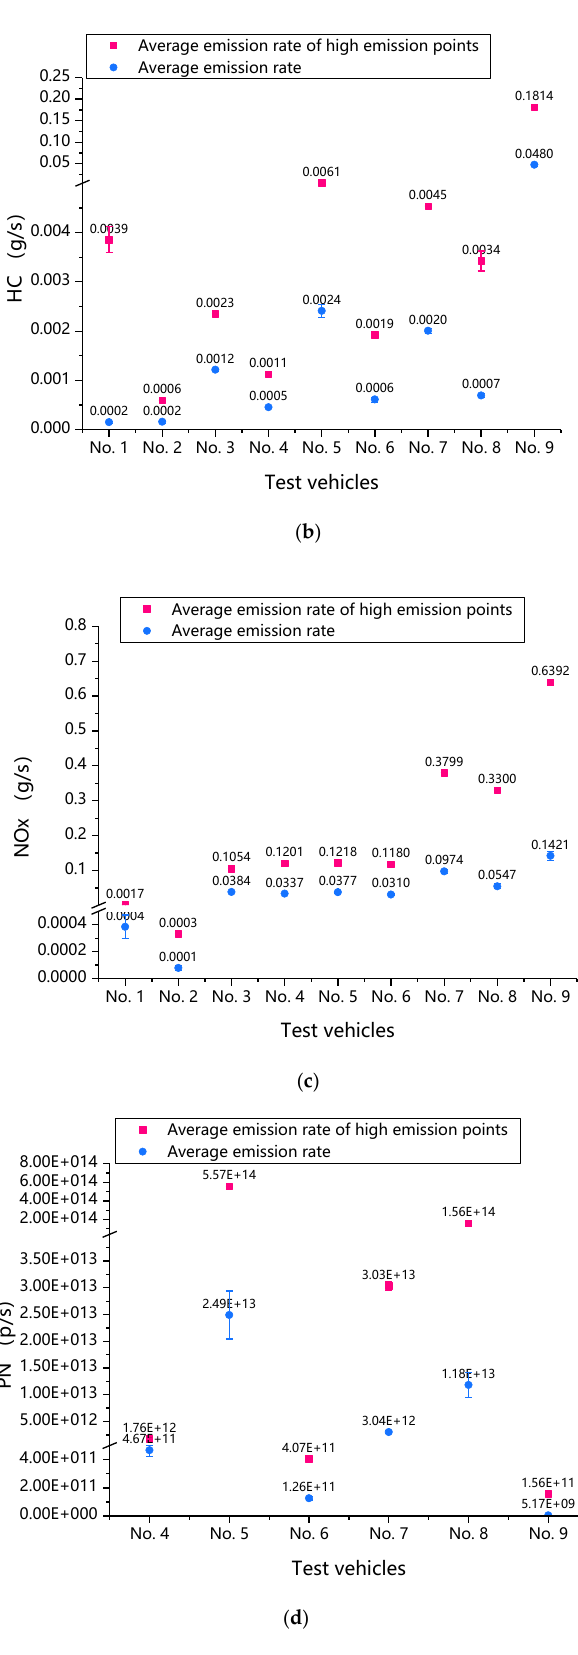
Figure 7. Comparison of the average emission rates (average ± 95% confidence interval) and the average emission rate of high-emission points per test vehicles. ( a ) The comparison of CO; ( b ) The comparison of HC; ( c ) The comparison of NOx; ( d ) The comparison of PN.